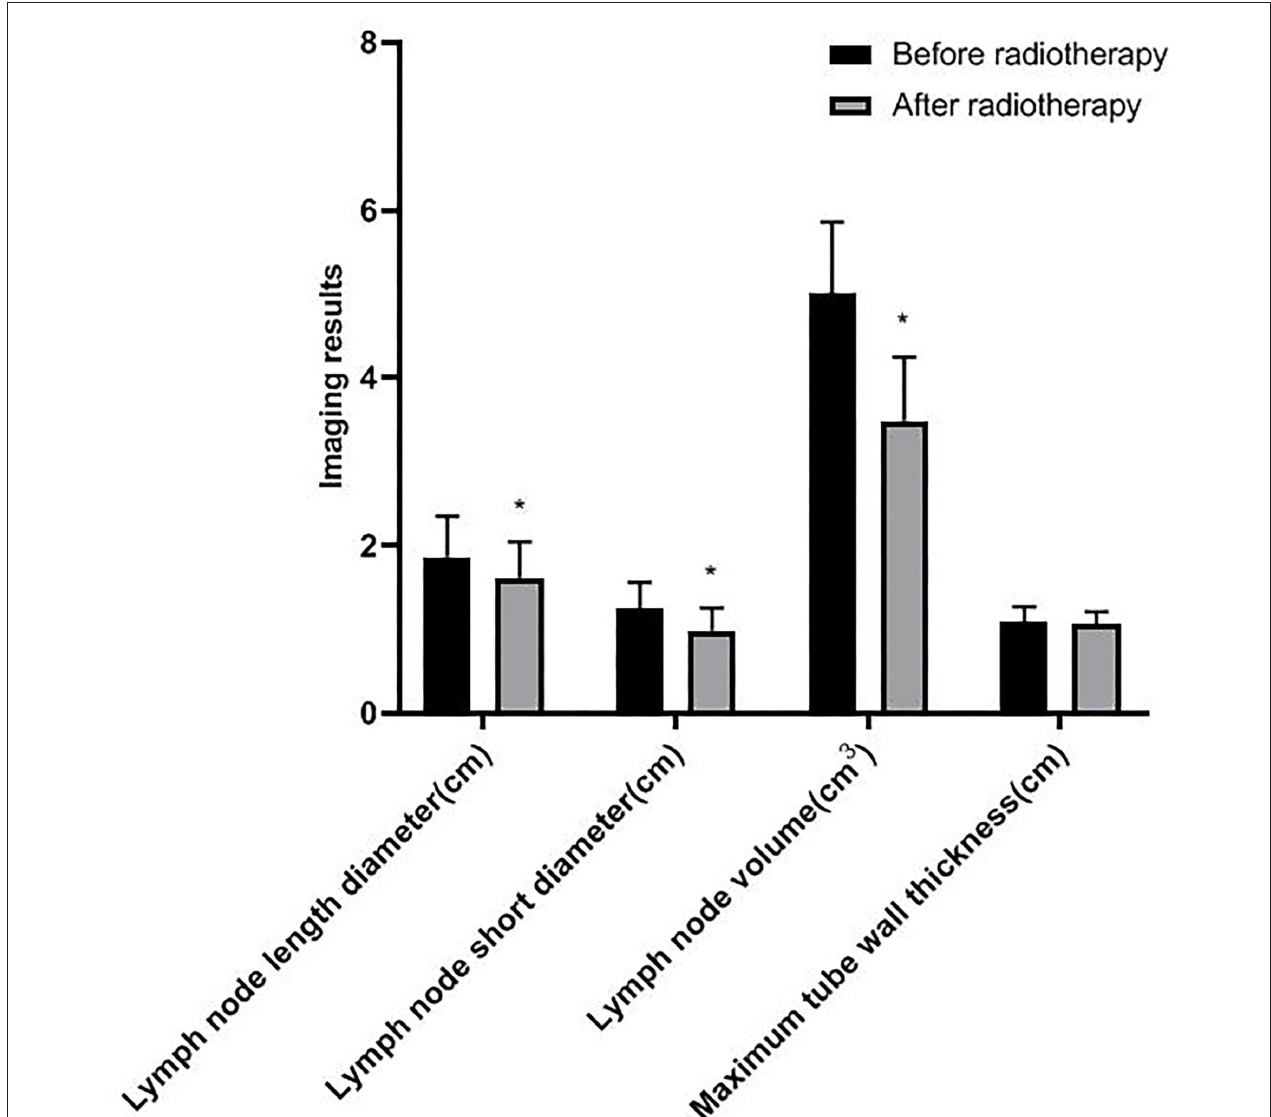
FIGURE 1 | Comparison of imaging results before and after radiotherapy. Compared with before radiotherapy, * p < 0.05.